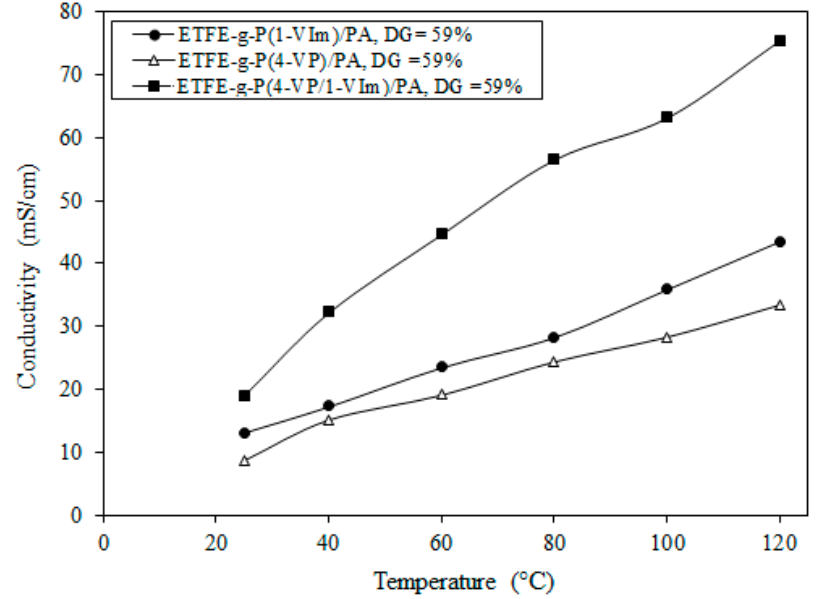
Figure 12. Variation of proton conductivity with temperature at anhydrous conditions for ETFE- g - P(4-VP/1-VIm)/PA compared to membranes obtained from the grafting of individual monomers.